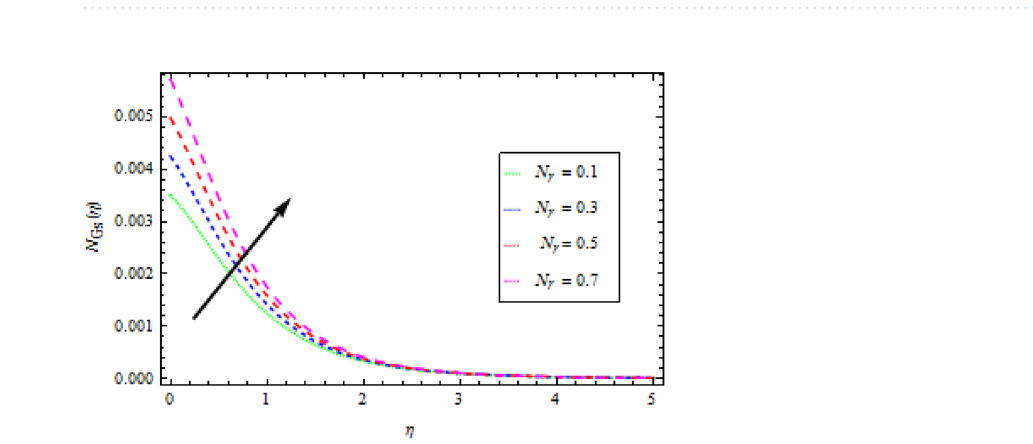
Figure 16. Effects of θ b on entropy generation.